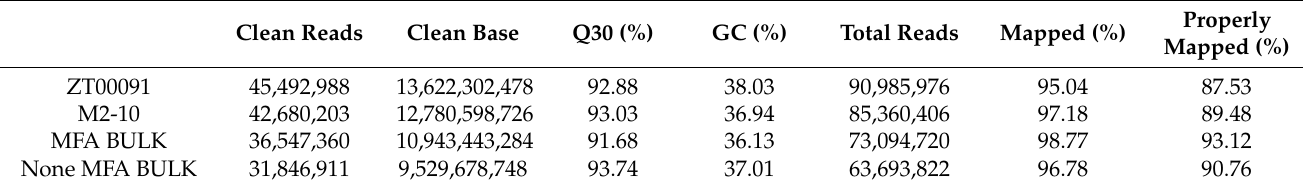
Table 2. Sequencing data for parental lines and